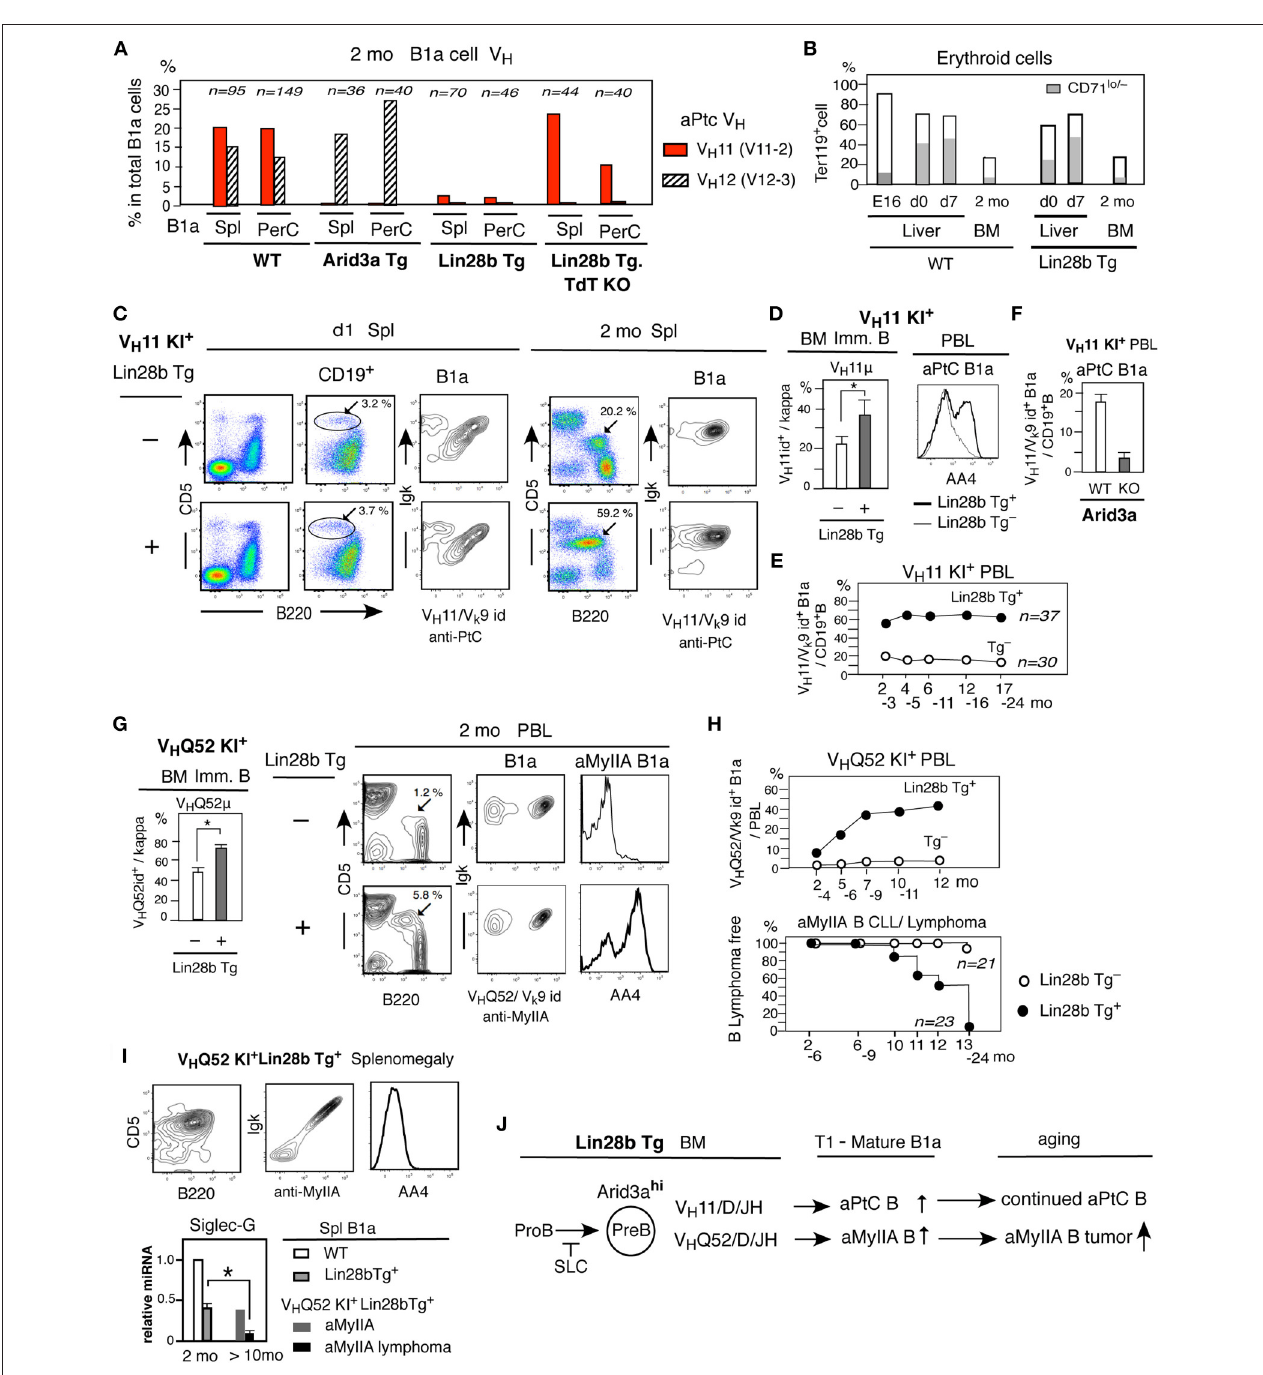
FIGURE 6 | SLC unassociated BCR B1a cell generation from adult Lin28b Tg BM and B1a lymphoma generation in aged mice. (A) Single cell sequence data of B1a cells in spleen and PerC in 2 mo WT (C.B17), Arid3a Tg, Lin28b Tg, and Lin28b Tg with TdT KO mice, and percentage of V H 11 + and V H 12 + B cells. (B) Percentage of erythroid cell (Ter119 + ) together with matured erythrocytes (Ter119 + CD71 lo / − ) in WT and Lin28b Tg + mice. WT mice; liver n = 2 each, 2 mo BM n = 5, mean. Lin28b Tg + mice; liver and 2 mo BM n = 3 each, mean. (C) Lin28b Tg mice crossed with V H 11 KI mice. B1a cell frequency in d1 and 2 mo spleen (marked), and V H 11 + aPtC cell dominance in B1a cells. (D) Left; 2 mo BM V H 11 µ + cell percentage in immature B cells in V H 11 KI mice with or without Lin28b Tg. n = 3 each; mean ± s.e. * P < 0.05. Right; AA4 staining of aPtC B1a cells in PBL (2 mo). (E) V H 11 + aPtC B1a cell percentage in PBL B cells with or without Lin28b Tg. Mean of Lin28b Tg + mice ( n = 37) and Lin28b Tg − mice ( n = 30) origin. (F) V H 11 KI.B6 mice crossed with mice to generate Arid3a KO and WT. V H 11 + aPtC B1a cells in PBL B cells in 2 mo Arid3a KO ( n = 4) and WT ( n = 5) littermates; mean ± s.e. (G) Lin28b Tg mice crossed with V H Q52 KI mice. Left; 2 mo BM V H Q52 µ + cell percentage in immature B cells in V H Q52 KI mice with or without Lin28b Tg. n = 3 each; mean ± s.e. * P < 0.006. Right; 2 mo PBL. B1a cell percentage (marked) with